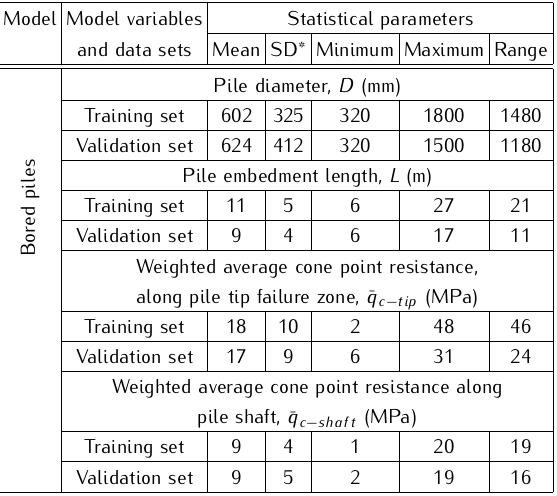
Table 1. ANN models input and output